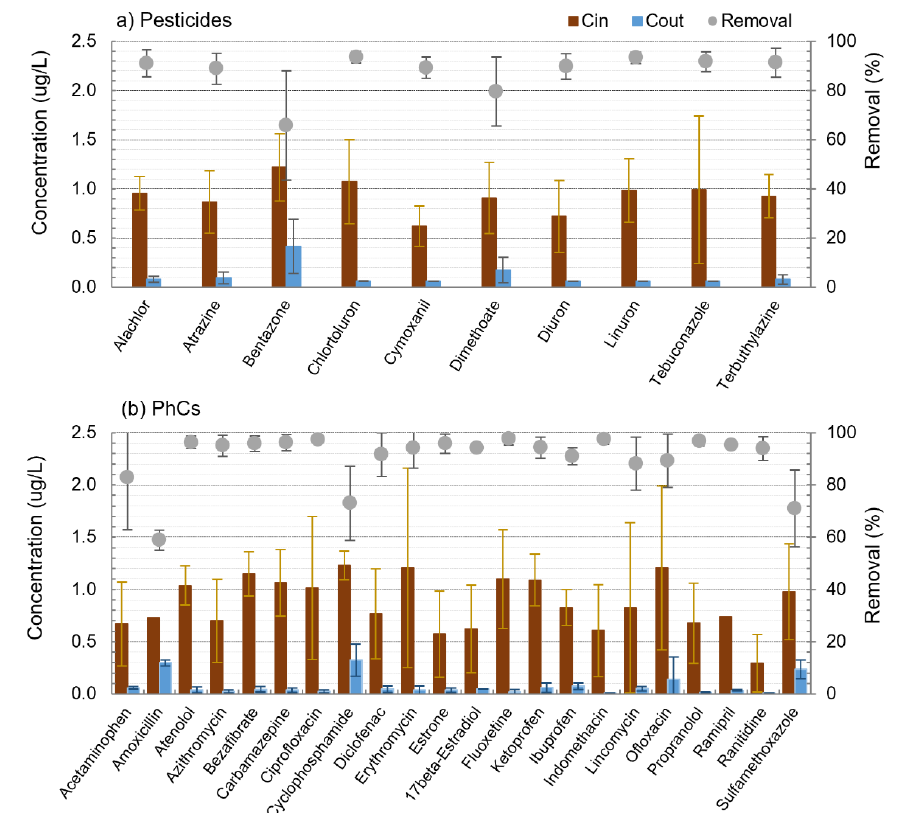
Figure 3. Average intake (brown bars) and permeate (blue bars) concentrations and removals (circles) of pesticides ( a ) and pharmaceuticals ( b ) after PAC/(Alum)/MF (average values of all spiking trials; error bars represent standard deviations between trials).